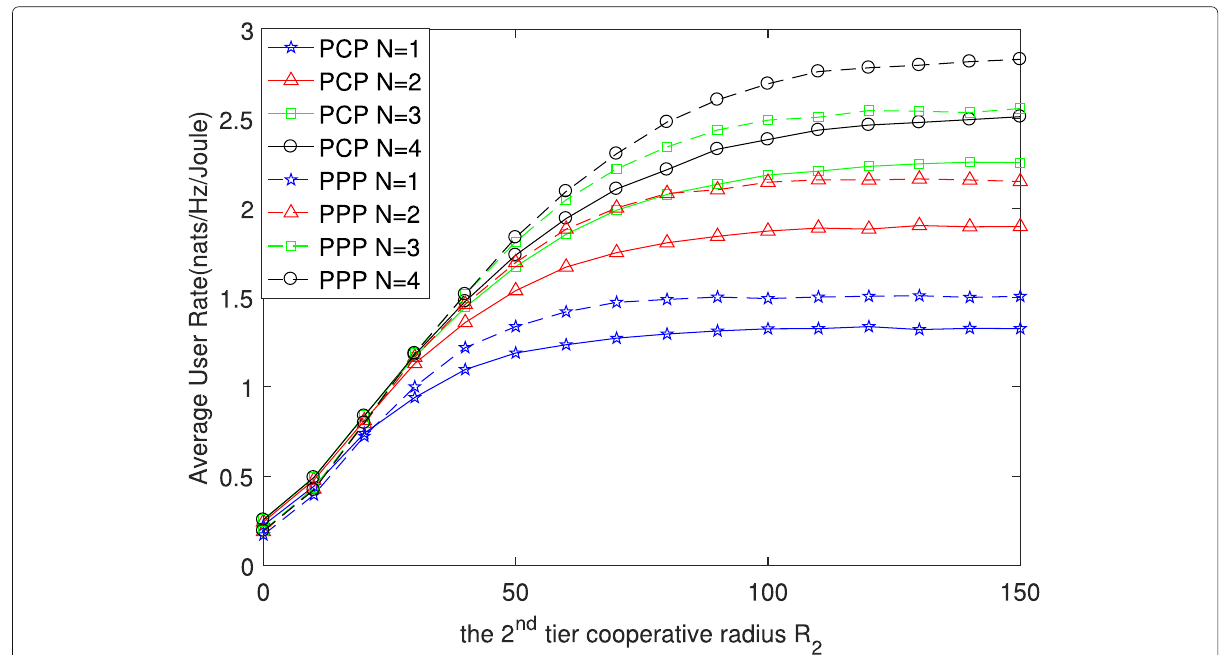
Fig. 8 The average achievable rates as a function of the number of cooperative BSs ( N =